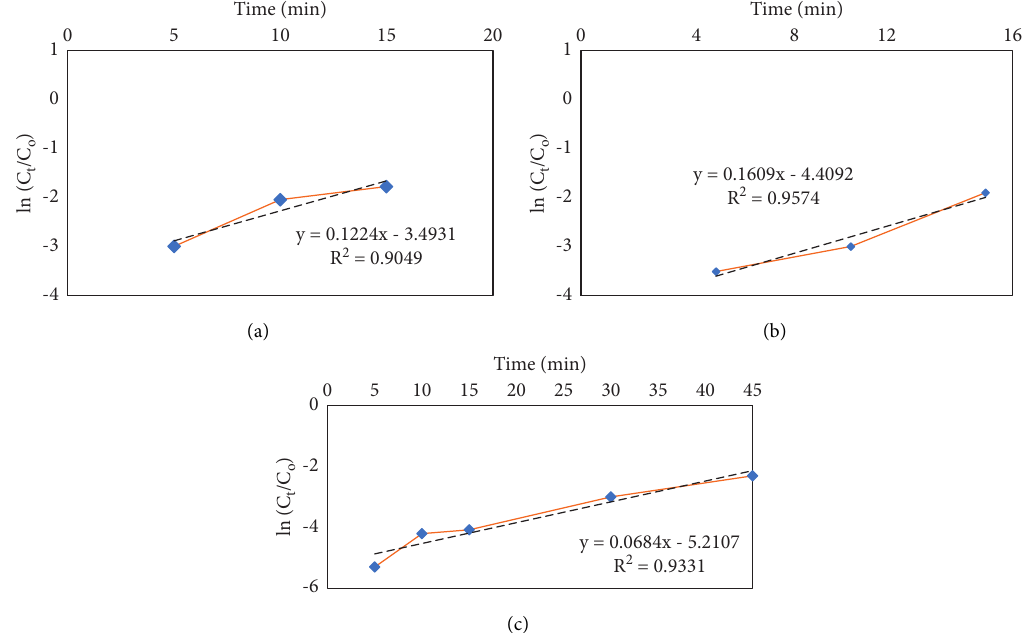
Figure 6: Adams–Bohart model linear form for cadmium removal. (a) For 3cm. (b) For 6cm. (c) Bed depth of